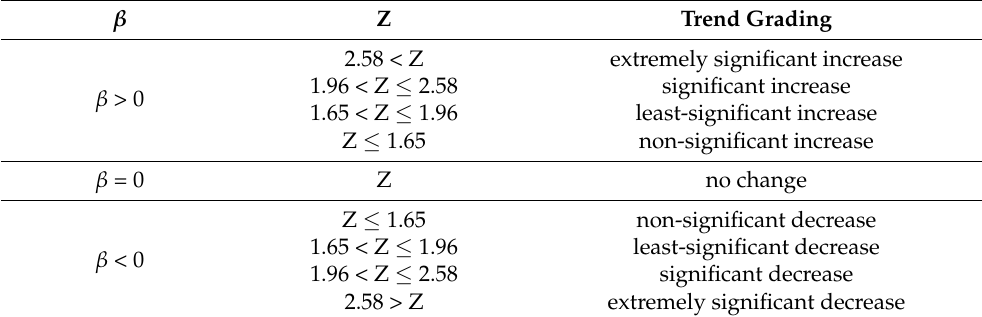
Table 5. Trend grading of MK test